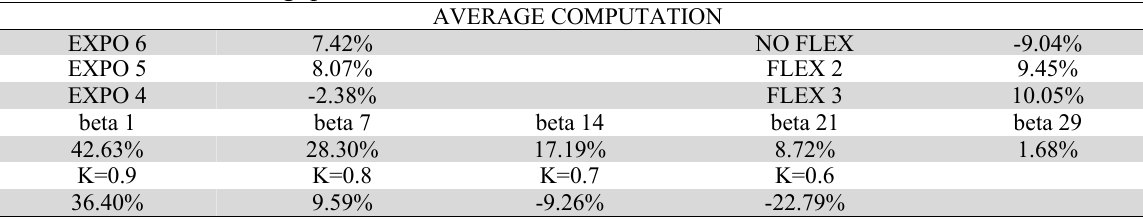
Simulation results – throughput